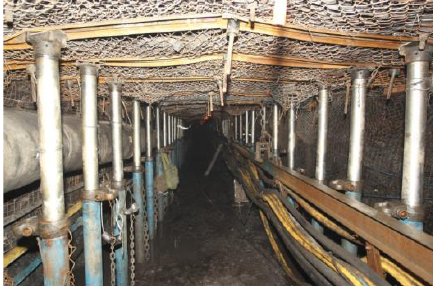
Figure 19. Advance reinforcement support.